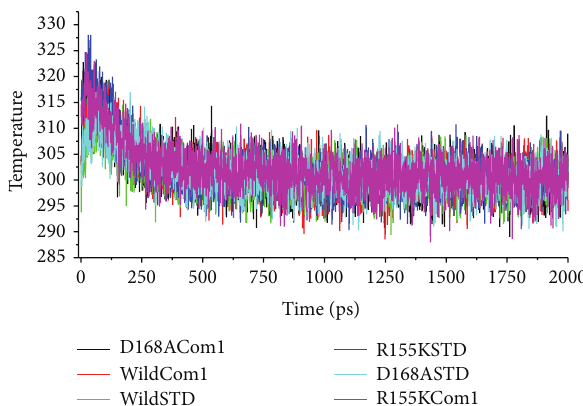
Figure 7: Ligand RMSD calculation plots for ligand bound com- plexes. The curves colored in blue and cyan show the instability of Asunaprevir inside the binding cavity of R155K and D168A mutants, respectively, while good stability is seen in wild type as shown by the green curve. Andrographolide is relatively very stable with very less deviation in the RMSD values for all the complexes (curves colored in black for R155K, red for D168A, and pink for wild-type structures, resp.). (Note: Asunaprevir is mentioned as STD and Andrographolide as Com